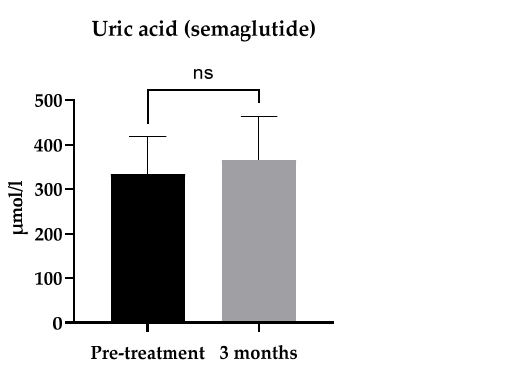
Figure 4. Change in uric acid after a 3-month treatment with semaglutide or empagliflozin. Statistics: paired t -test; mean ± SD, ns: p ≥ 0.05; * p < 0.05.